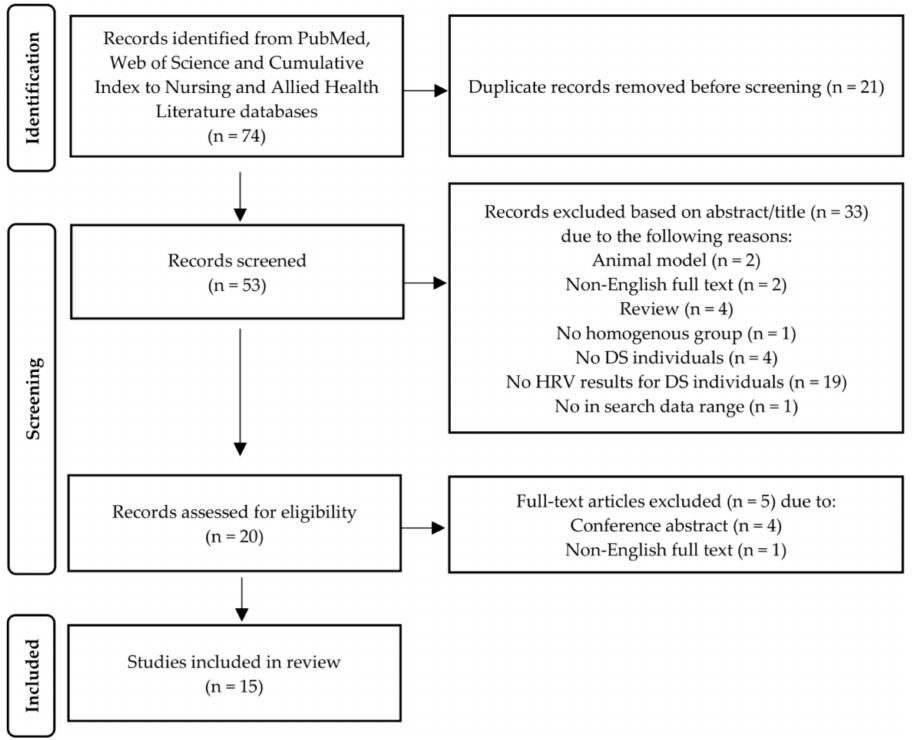
Figure 1. Flow diagram for the search process (PRISMA flow